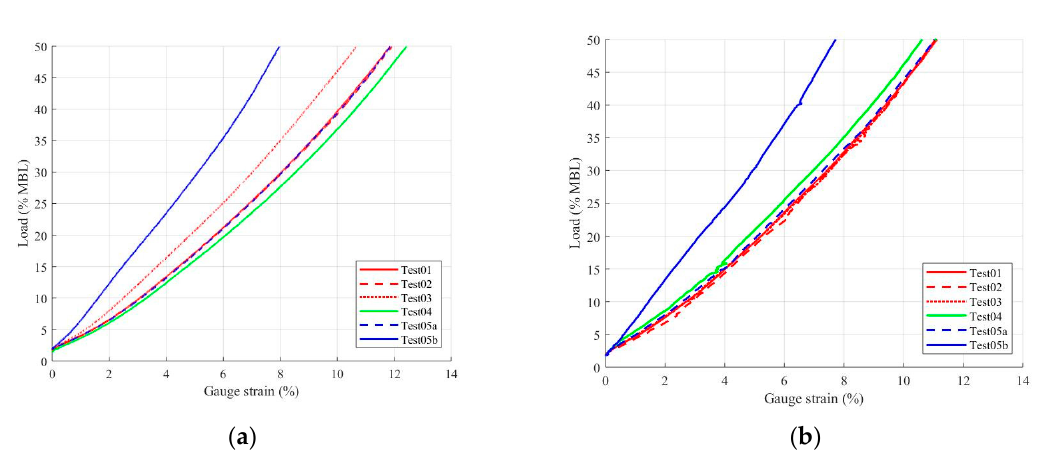
Figure 7. First loading of samples at (a) DMaC and (b) IFREMER.